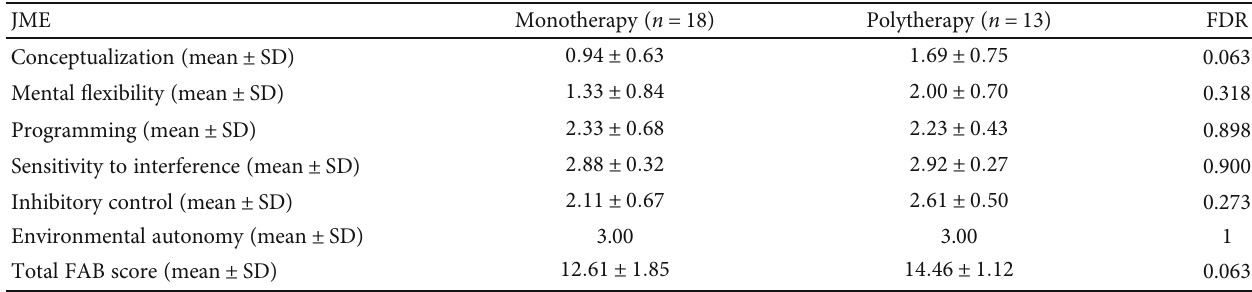
Figure 2: Comparison of FAB subset scores between JME patients with and without recent seizures. Table 4: Comparing FAB scores between monotherapy and polytherapy groups controlling for age, sex, family history, disease duration, and multiple